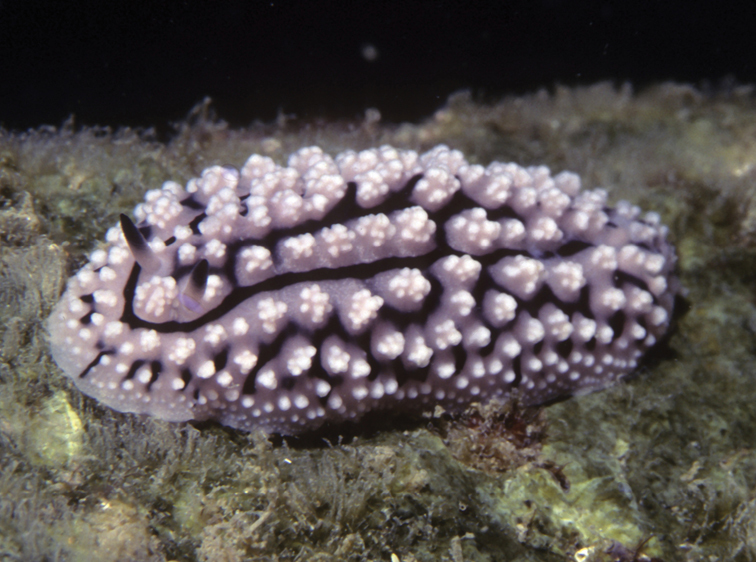
Phyllidiopsis krempfi, 40 mm pres., Sri Lanka, photo: RC Anderson.